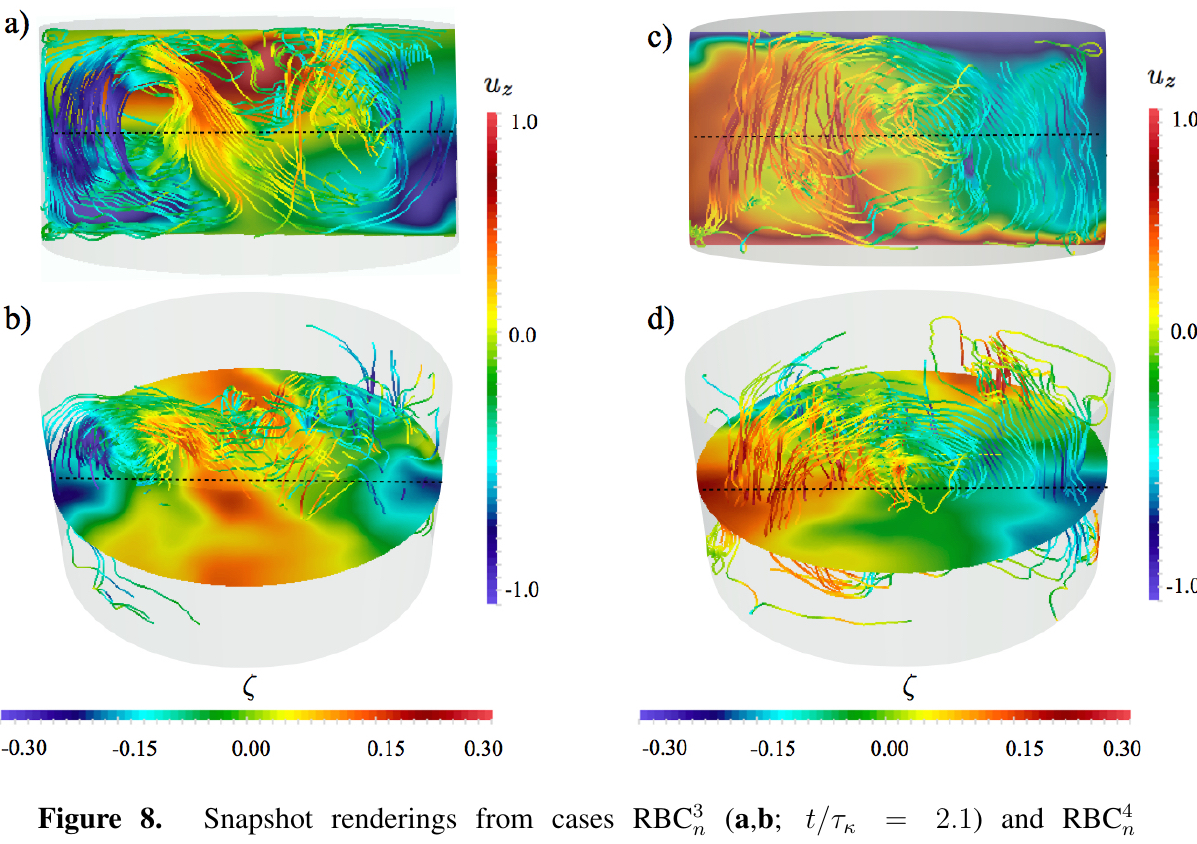
= 2 . 1 ) and RBC 4 ( a , b ; t/τ κ n n case is shown n does not n